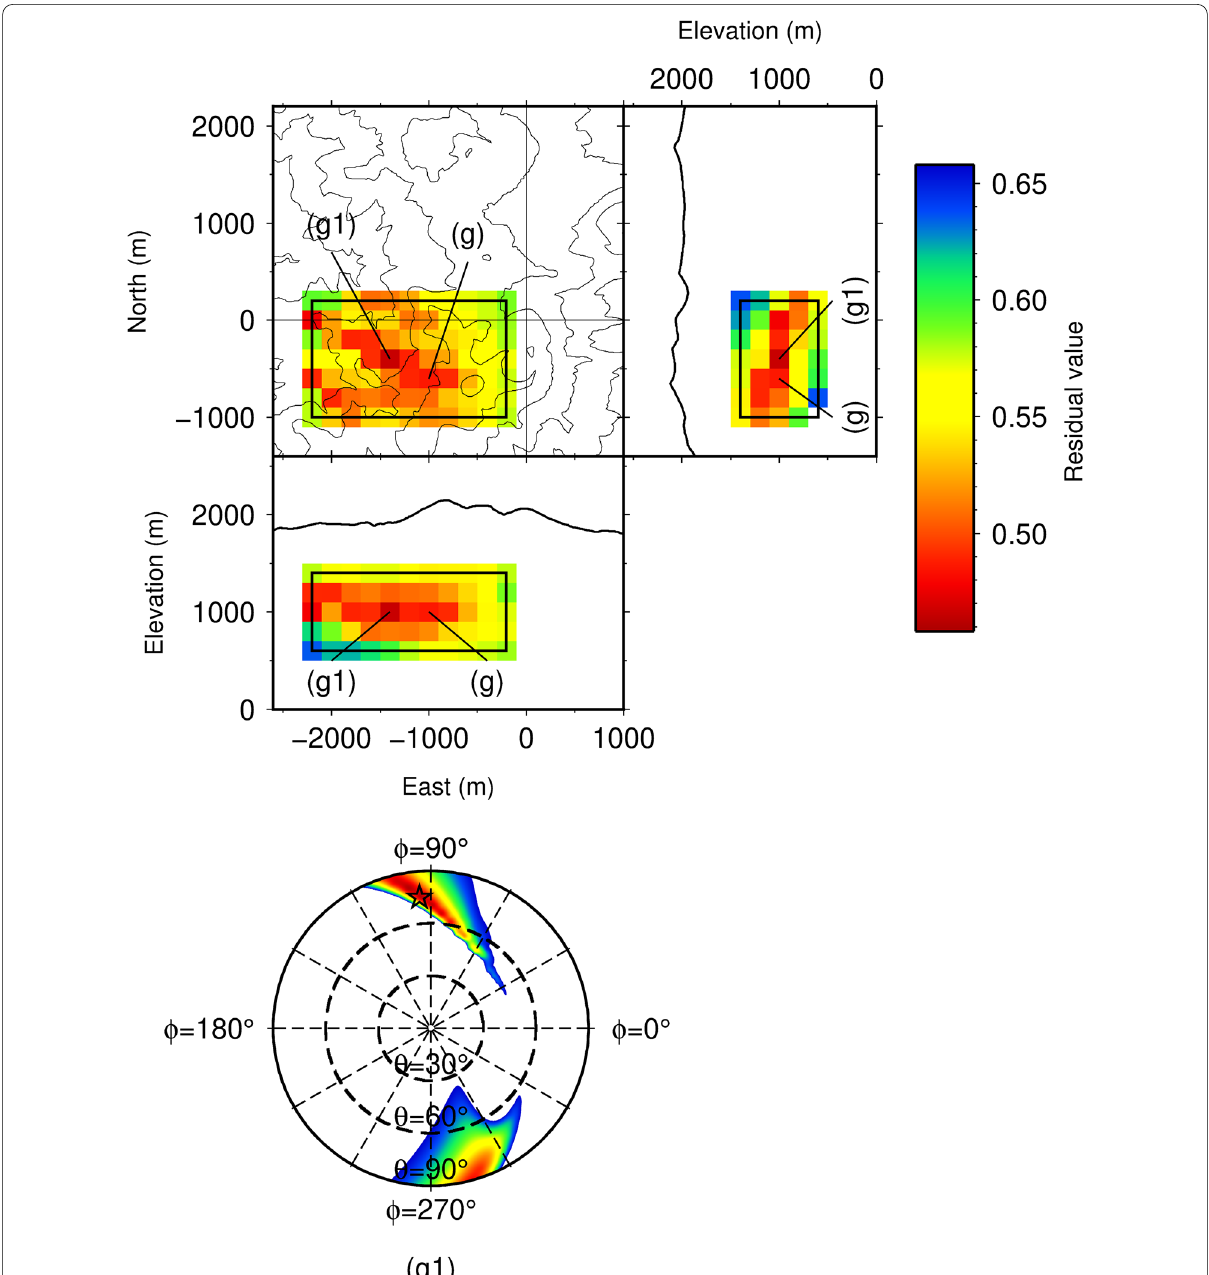
Fig. 15 Spatial distribution and crack orientation dependence of the residuals between the observed and synthetic waveforms obtained by a second grid search about candidate ( g ). The locations of candidates ( g ) and ( g1 ) are indicated by straight lines on the plane map. See Fig. 5 for details concerning the plotting